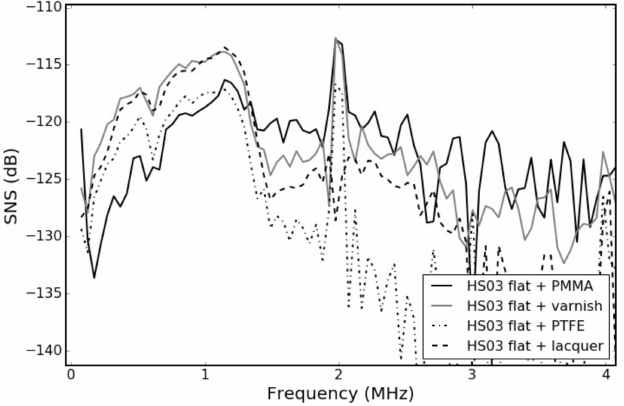
Figure 8. SNS vs. frequency for flat HS03 transducers in pulse-echo mode in water with di ff erent